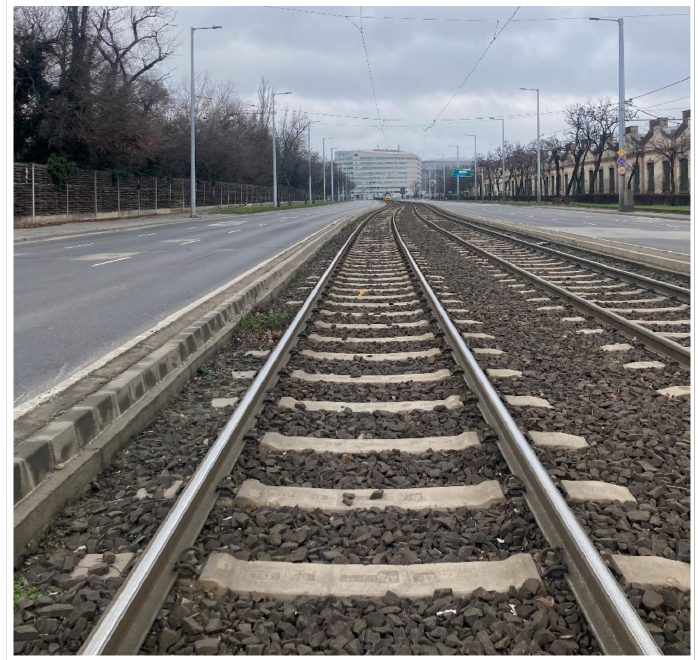
Figure 4. Photo of Section #4 (own photo).